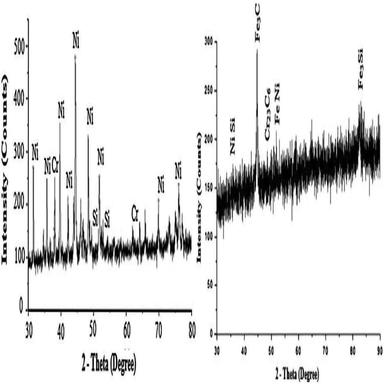
XRD results of a 1018 mild steel joint after microwave welding .